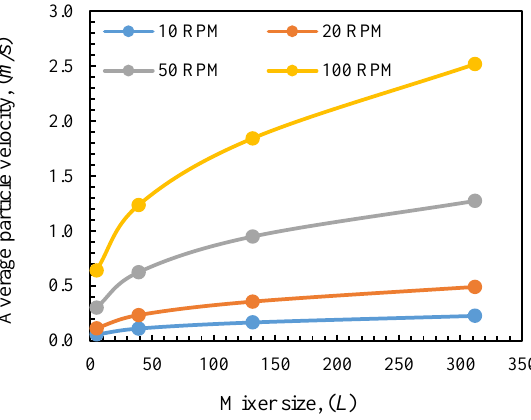
Fig.5 : The average particle velocity at steady-state as a function of rotation speed and mixer sizes.